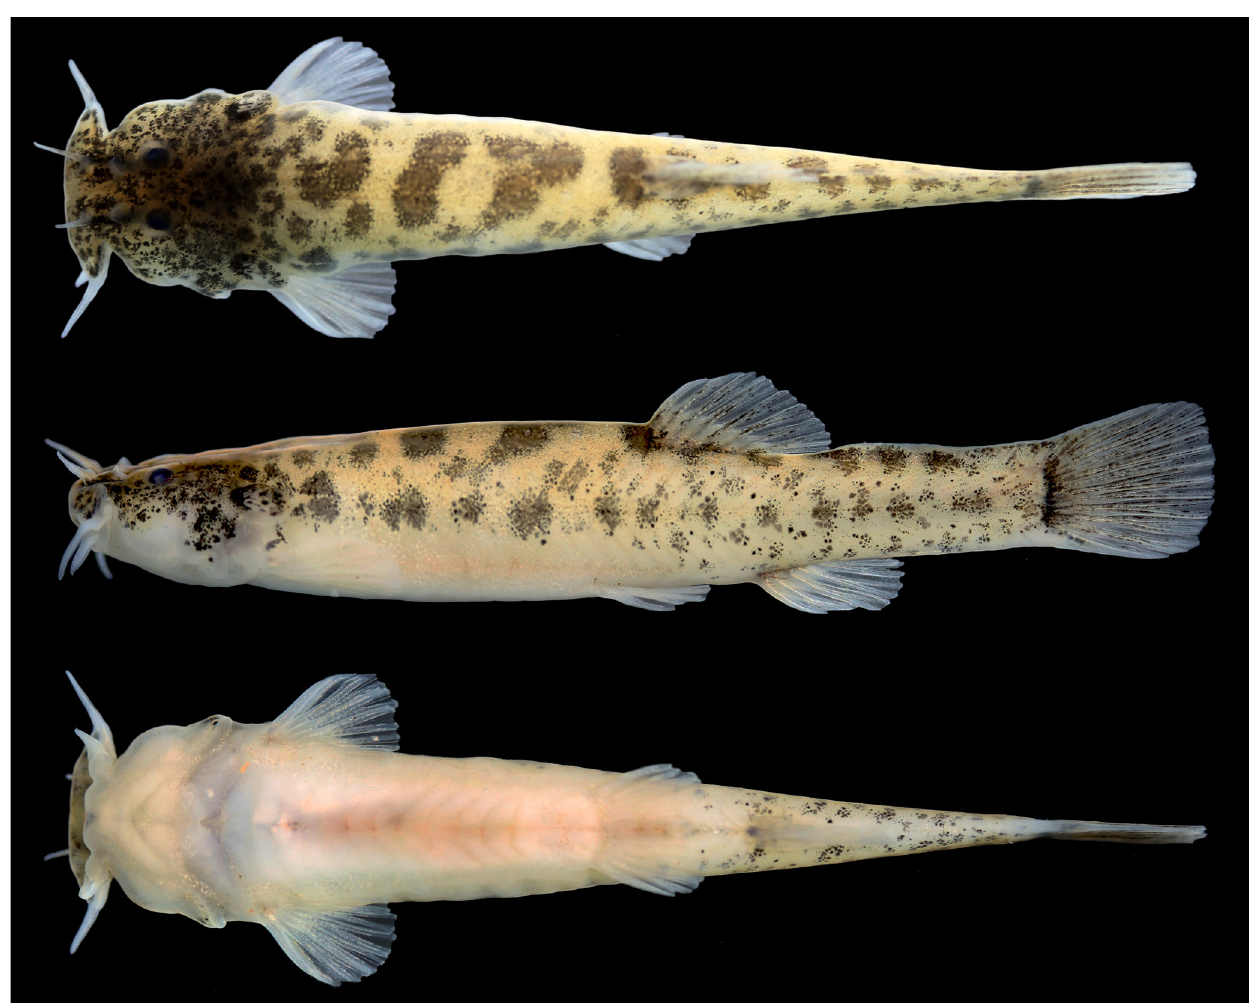
FIGURE 7 | Scleronema guapa just after the fixation in formalin, paratype (UFRGS 18087, 32.0 mm SL), Brazil, Rio Grande do Sul, Rosário do Sul, sanga Santo Antônio, tributary to rio Ibicuí da Armada, lower rio